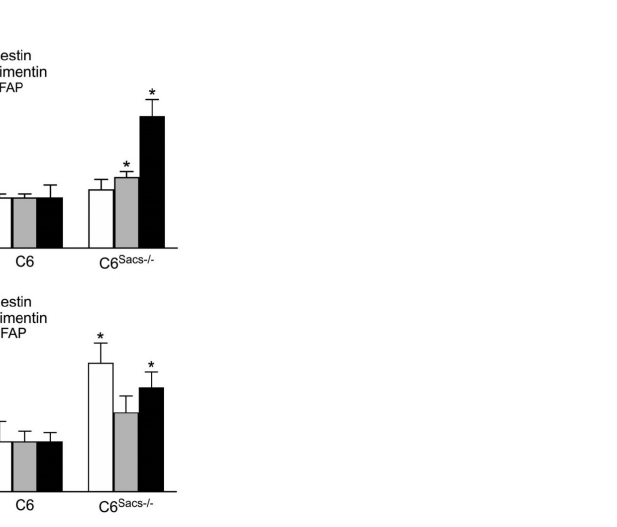
Figure 4. Sacsin deletion increases protein levels and aggregation of glial intermediate filaments. ( A ) Representative Western blots showing the expression patterns of the glial intermediate filaments. ( B ) Densitometric analysis of Western blots from at least 3 independent experiments normalized versus GAPDH. The levels of GFAP and vimentin proteins are increased in C6 Sacs − / − cells. ( C ) Filter trap assays confirmed higher aggregation of intermediate filaments in C6 Sacs − / − cells. ( D ) Densito- metric analysis of filter traps normalized versus the reference C6 strain. *, significant vs. C6 reference strain ( p < 0.05, Student’s t -test).